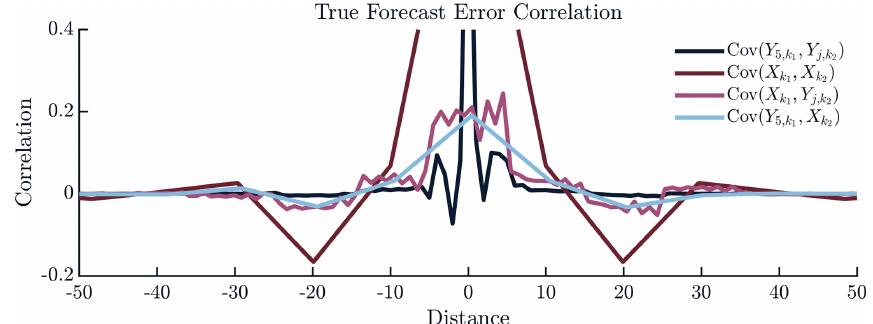
Figure B1. True forecast error correlations for variables in the middle of each sector, X k and Y 5 ,k . Correlations between Y variables (dark blue) decay to zero after about 5 spatial units, while correlations between X variables (dark red) are significant up to 40 spatial units away. Cross-correlations (pink and light blue) are small everywhere but still significant out to at least 20 spatial units.